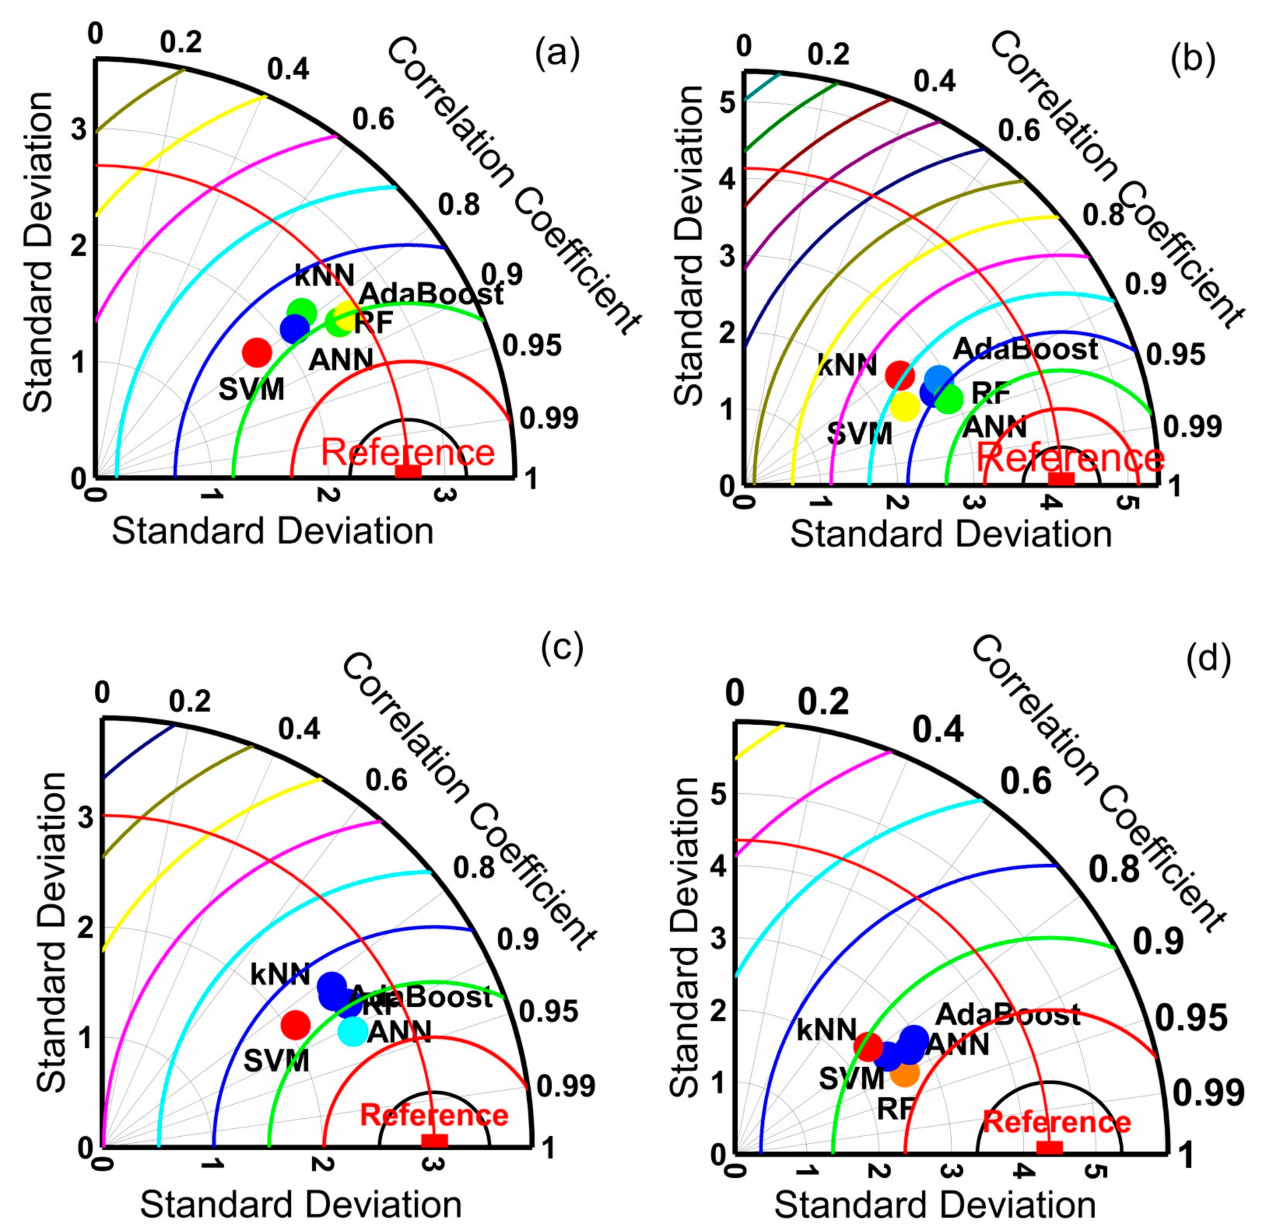
Figure 4. Taylor diagrams for comparing trained machine learning models, namely random forest (RF), adaptive boosting (AdaBoost), artificial neural network (ANN), and k-nearest neighbor (kNN). ( a ): Comparison of the ML models for predicting suspended sediment load at Aguibat Ziar station; ( b ): comparison of the ML models for predicting SSL at Ras Fathia station; ( c ): comparison of the ML models at SM Cherif station; ( d ): comparison of the ML models at Ain Loudah